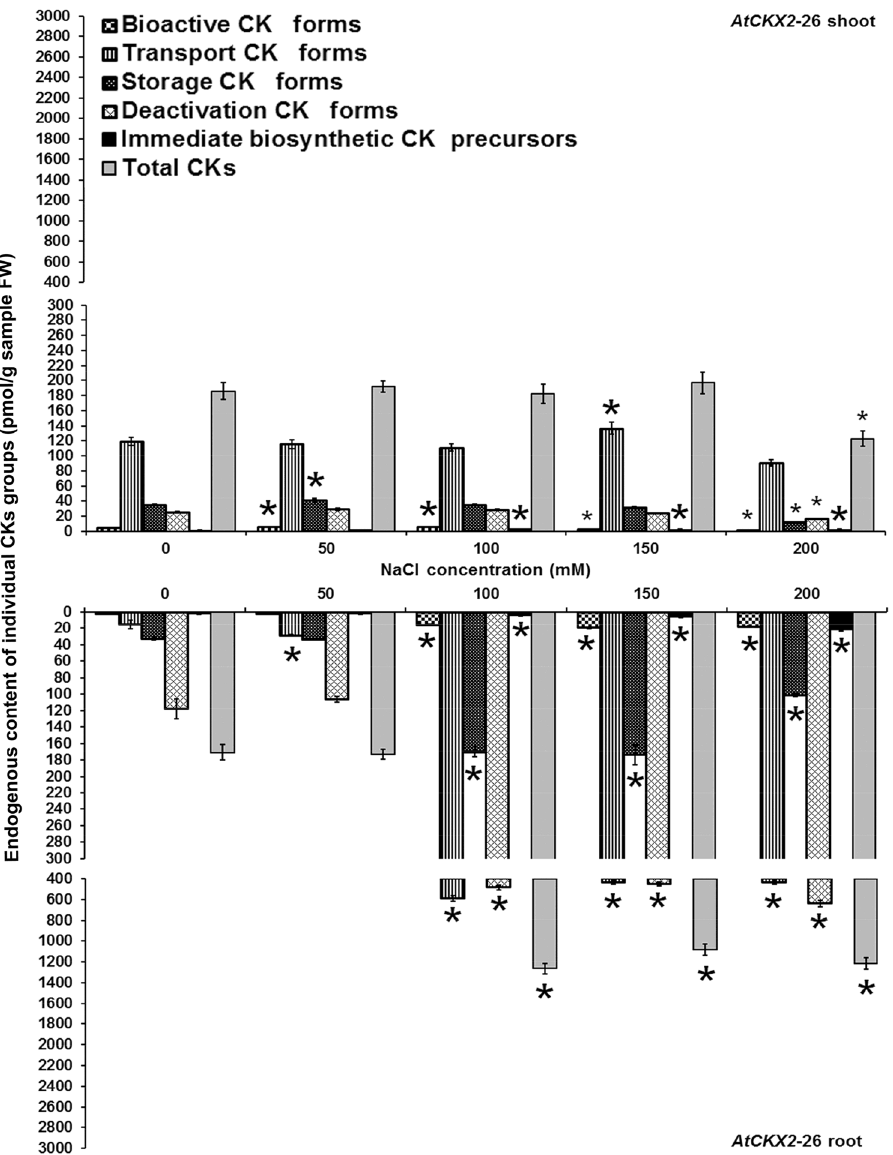
Figure 4. Endogenous cytokinin content in shoots and roots of 8-week-old AtCKX2 -26 transgenic Centaurium erythraea line. According to physiological function and conjugation status cytokinins were divided into five groups including bioactive forms (DHZ, iP, tZ , c Z), transport forms (DHZ9R, iP9R, t Z9R, c Z9R), storage forms (DHZ9ROG, DHZOG, t Z9ROG, t ZOG, c Z9ROG, c ZOG), deactivation forms (DHZ7G, DHZ9G, iP7G, iP9G, t Z7G, t Z9G, c Z7G, c Z9G), immediate biosynthetic precursors ( t ZRMP, DHZRMP, c ZRMP, iPRMP) and total CKs content (boja kolone). Data represent mean ± standard error. Means marked with asterisks are significantly different from corresponding control values (LSD test, p ≤ 0.05). The bigger asterisks represent the values significantly higher than control ones while smaller asterisks represent values significantly lower than control